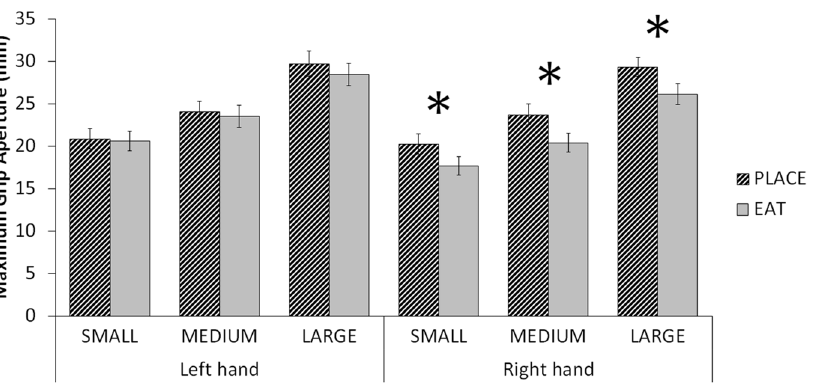
Figure 3. MGA displayed by Hand 6 Task 6 Size. The observed Hand 6 Task interaction (Fig. 2) is consistent across all size conditions. Significance shown (*) has been Bonferroni-adjusted for 6 tests ( p , .00833).